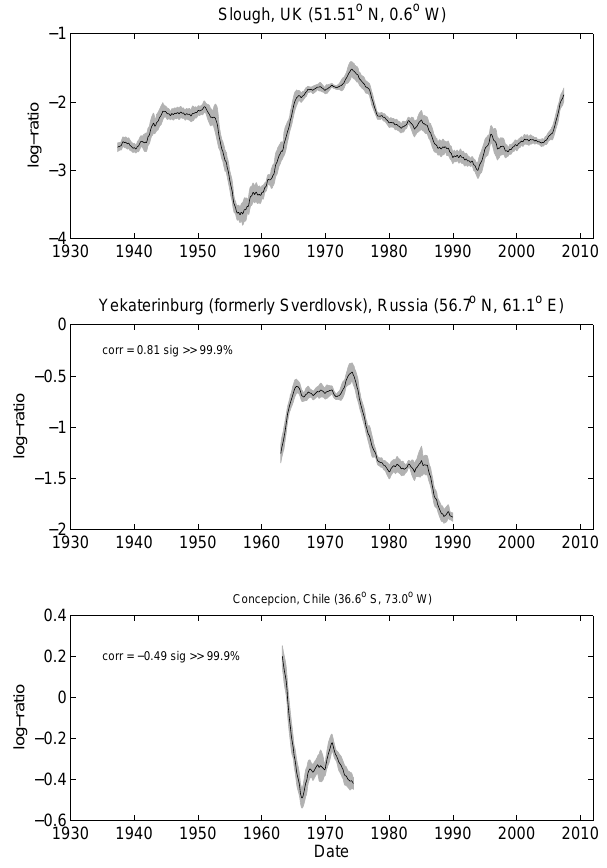
Figure 1. Log power ratios of the semi-annual to annual compo- nents of noon median values of fo F2 (black lines) against time for three ionospheric monitoring stations; Slough/Chilton (top), Sverdlovsk (middle) and Concepción (bottom). The standard error for each station is shown as a grey band around the black line. For the two lower panels, the value and significance of the correlation with Slough is shown.